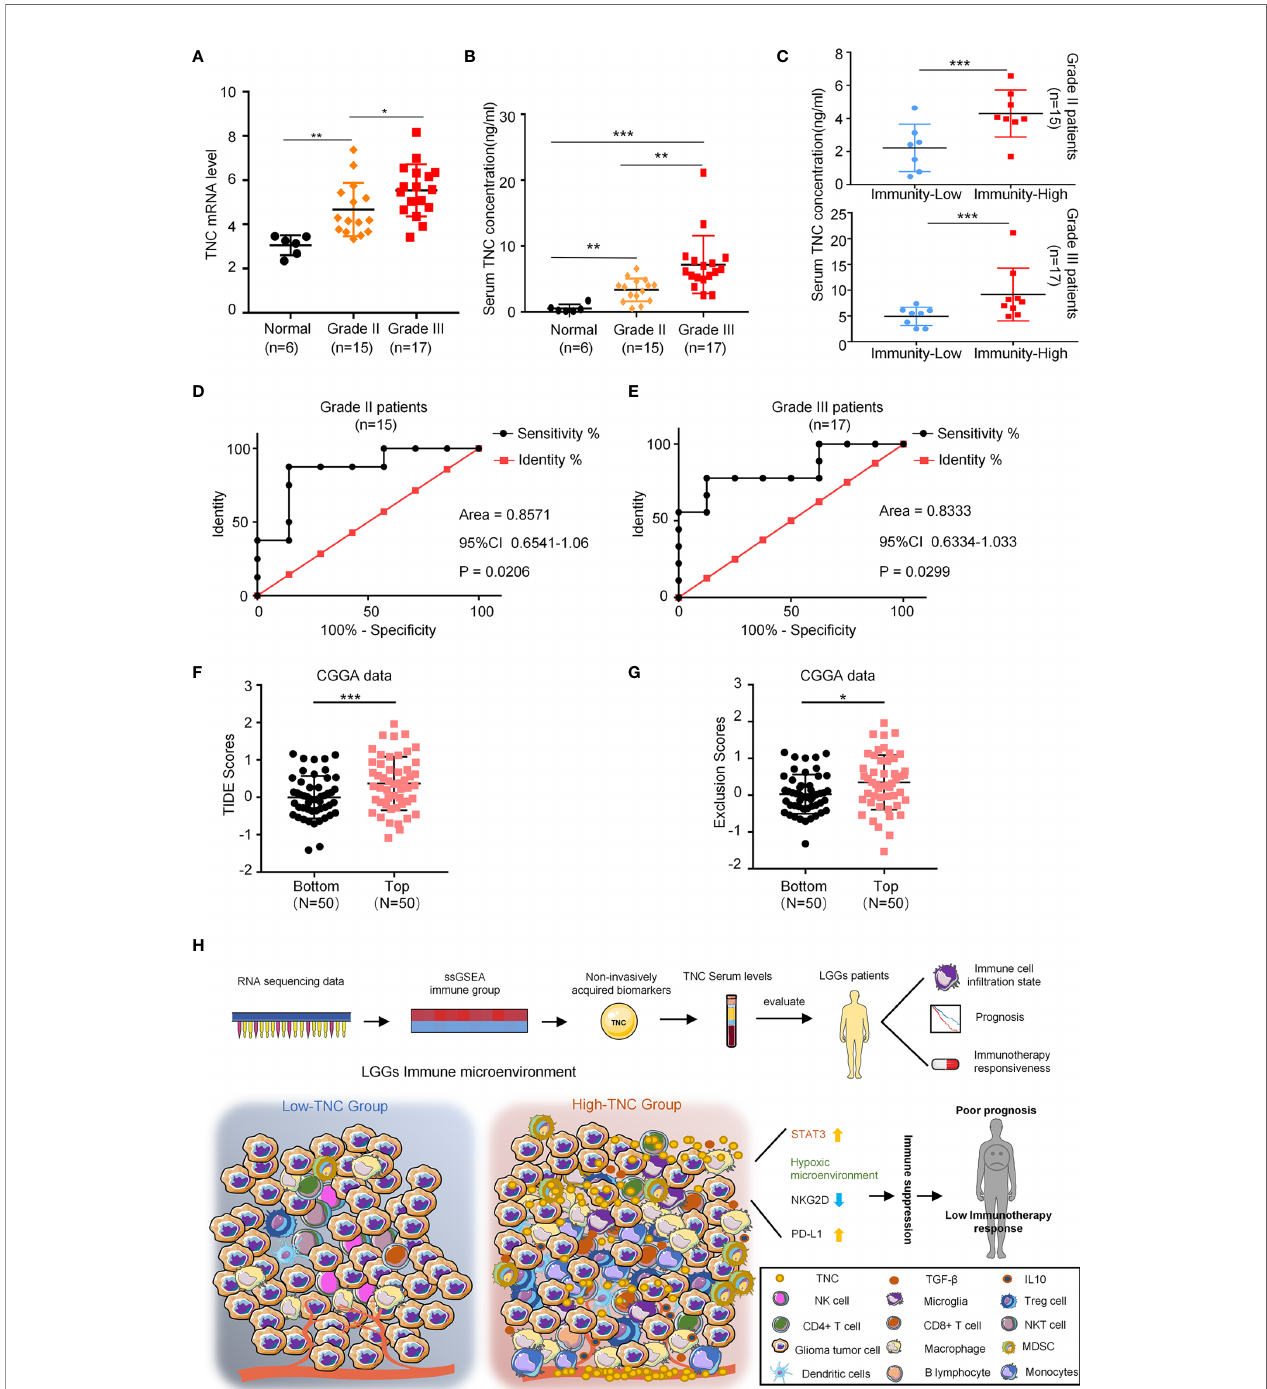
FIGURE 5 | Serum TNC can re fl ect the immune microenvironment of LGGs and predict the effect of immunotherapy. (A) qRT-PCR analysis of mRNA expression of TNC in normal brain tissues ( n = 6), grade II ( n = 15) and grade III ( n = 17) glioma patients. (* p < 0.05; ** p < 0.01) (B) Scatter plot displaying the serum concentration of TNC in normal brain tissues ( n = 6), grade II ( n = 15) and grade III ( n = 17) glioma patients. (** p < 0.01; *** p < 0.001) (C) Scatter plot demonstrating the correction between TNC serum concentration and immunity-status in grade II and III glioma patients (Grouped based on the median of the tumor CD11b mRNA level. *** p < 0.001; n = 32) (D, E) ROC curves showing the diagnostic value of serum TNC level for distinguishing the status of LGG immune microenvironment. (F, G) TIDE scores and T cell exclusion scores in different TNC mRNA expression subgroups. The score between the two subgroups were compared through the Wilcoxon test. (Top: TNC high expression; Bottom: TNC low expression. * p < 0.05, *** p < 0.001) (H) The potential application of TNC in the early diagnosis and individualized treatment of LGG